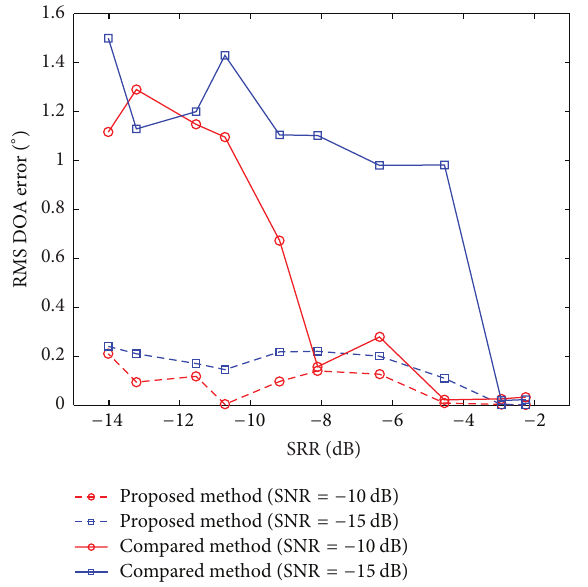
Figure 11: The RMS DOA errors with two methods over different SRR values and SNR is equal to −